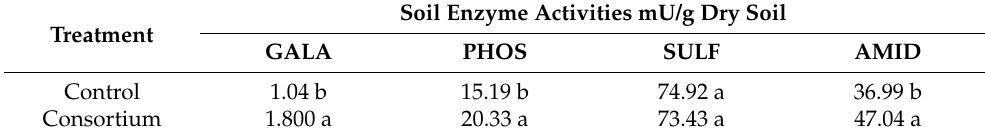
Table 3. Effect of bacterial inoculation on soil enzymatic activities: galactosidase (GALA), phosphatase (PHOS), arylsulfatase (SULF) and arylamidase (AMID) of the rhizospheric soil of M. sativa plants under NaCl stress. Values with different letters are significantly different ( p = 0.05). Means that do not share a letter are significantly